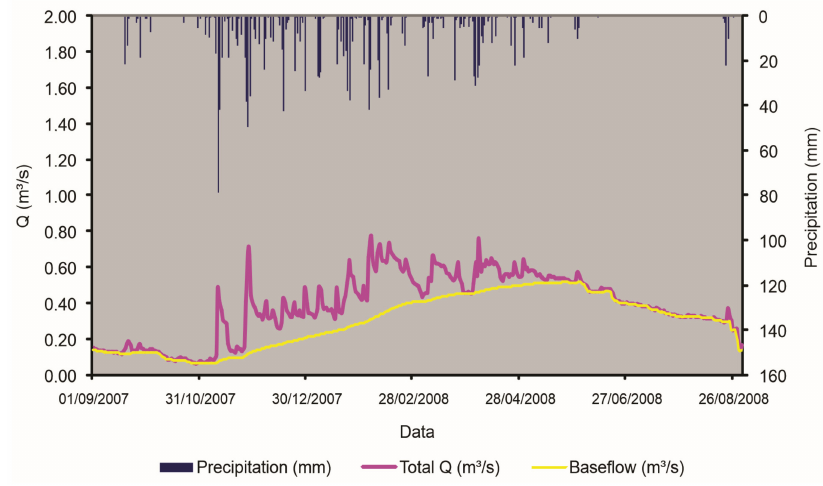
Figure 14. Hydrograph of surface flow and baseflow for 2008/2009.